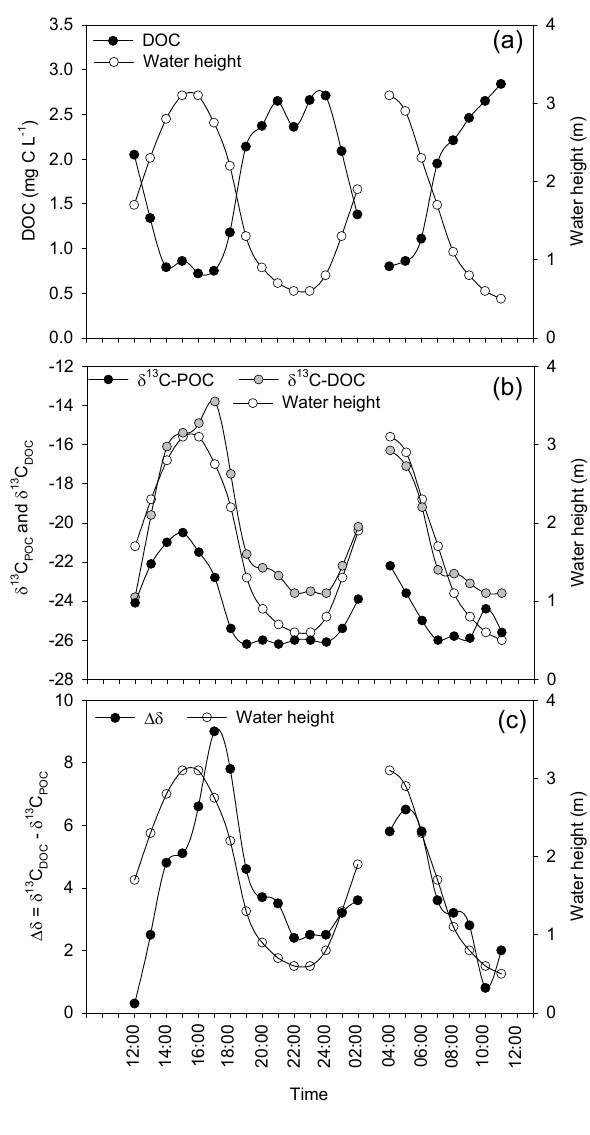
Figure 4 Fig. 4. Tidal variations of water height and (a) dissolved organic carbon concentrations, (b) carbon stable isotope signatures in par- ticulate and dissolved organic carbon, and (c) the difference in δ 13 C between DOC and